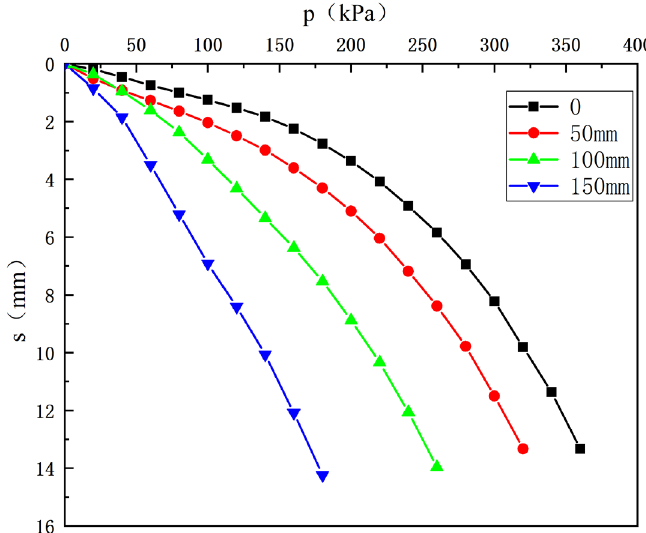
Figure 4. The p–s curves at different water levels.